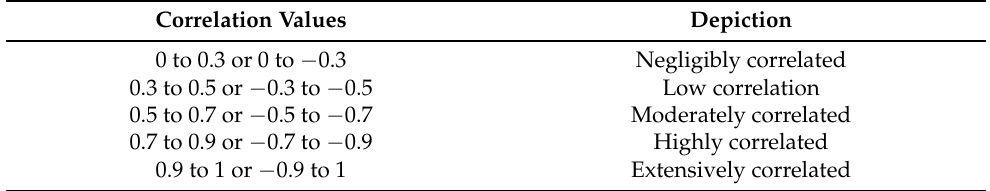
Table 2. Definition of correlation